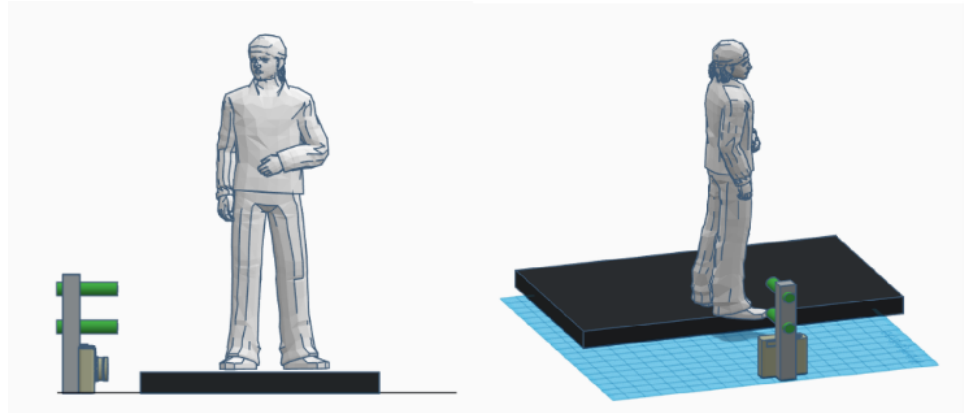
Figure 2. This image shows the MFCE device setup on the sidewalk. The device is placed on the street facing the sidewalk, with the center of the camera aligned to the sidewalk plane. The system will record passerby gait information and analyze the foot clearance automatically. No additional set-up is required.